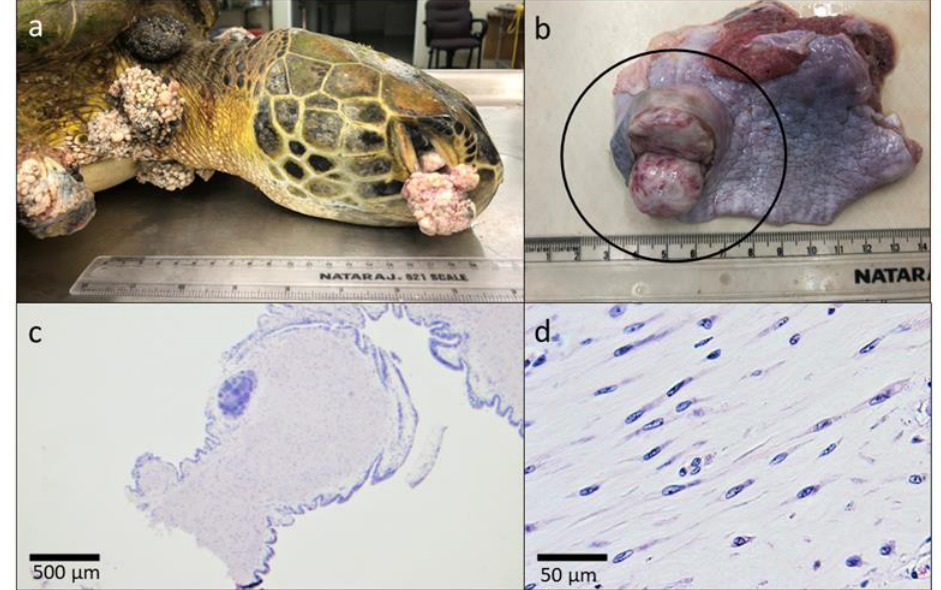
Figure 1. Necropsy findings of the first confirmed case of fibropapillomatosis in Grenada in a green turtle ( Chelonia mydas ). Gross appearance of ( a ) fibropapillomas extending from the conjunctiva of the eye, the neck, and the shoulder and ( b ) incised fibroma within the parenchyma of the lung. Tumor histomorphology under ( c ) 2× magnification demonstrating pedunculated appearance and ( d ) 40× magnification showing well differentiated spindle cells separated by an abundant fibrovascular stroma.